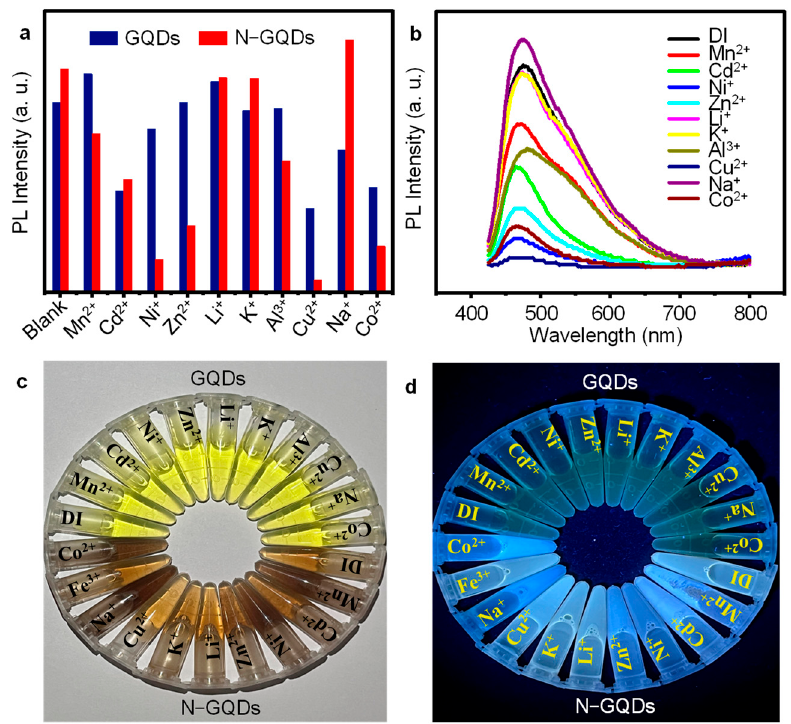
Figure 5. ( a ) Fluorescence intensity histograms of GQDs and N–GQDs in different metal ion solutions. ( b ) Fluorescence spectra of N–GQDs in different metal ion solutions. Images of GQDs and N–GQDs in solutions of different metal ions under natural light ( c ) and ultraviolet light ( d